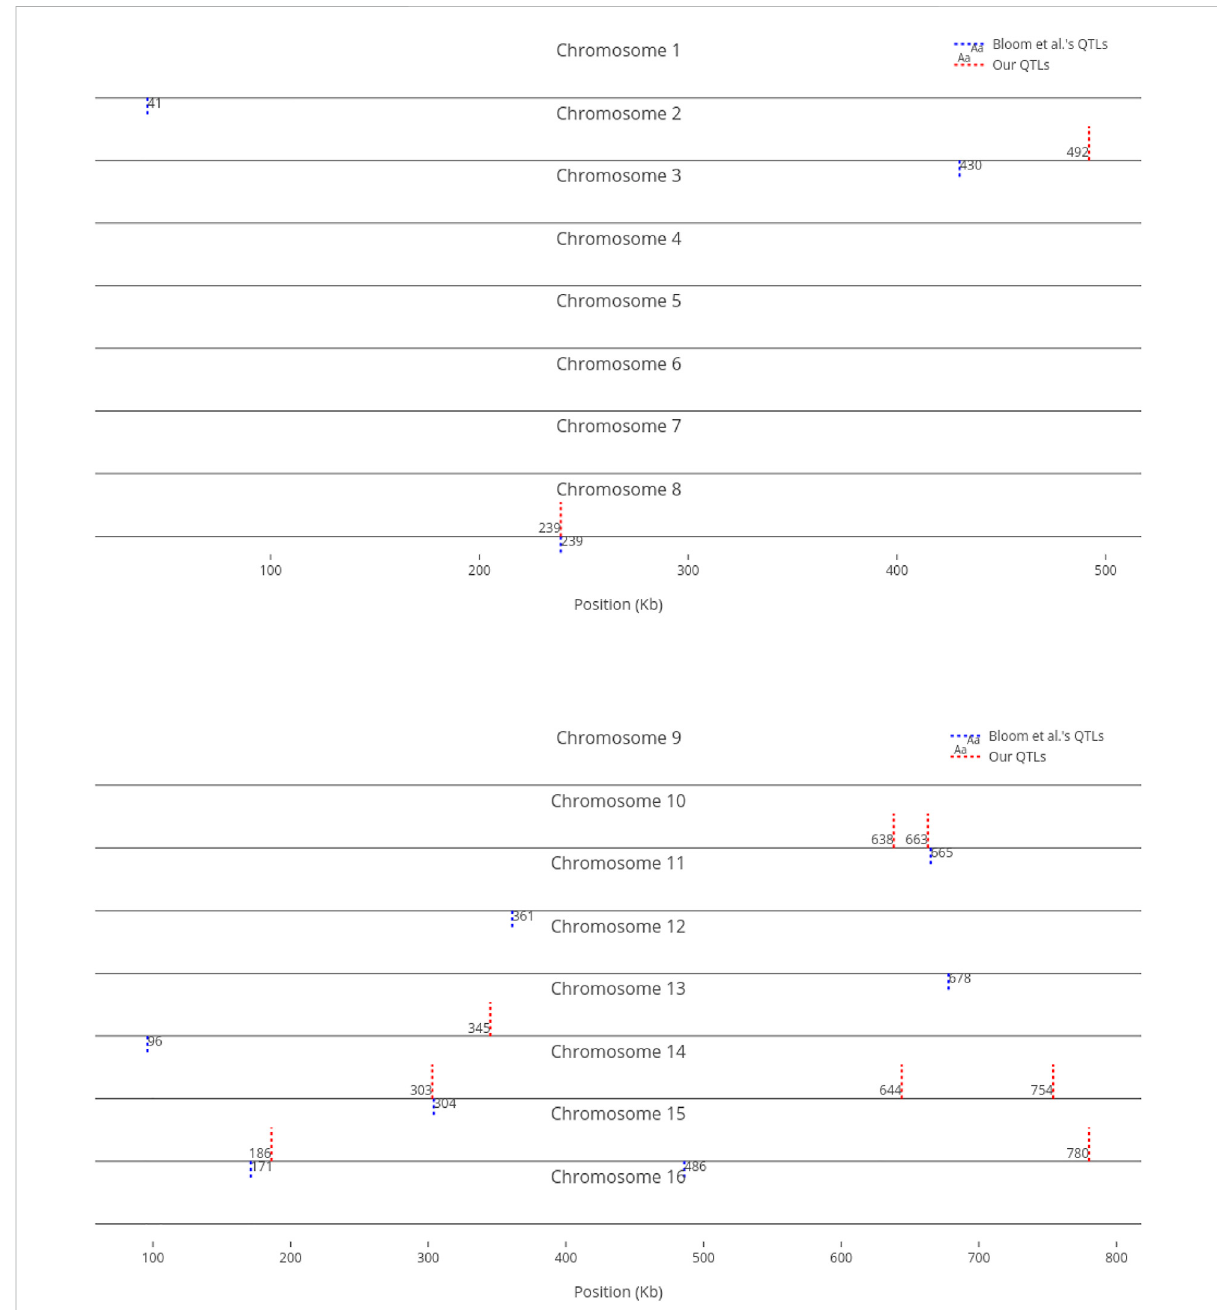
FIGURE 4 Top 10 in fl uential markers on growth in Mannose recognized by ensemble RVMs versus Bloom et al. ‘ s 10